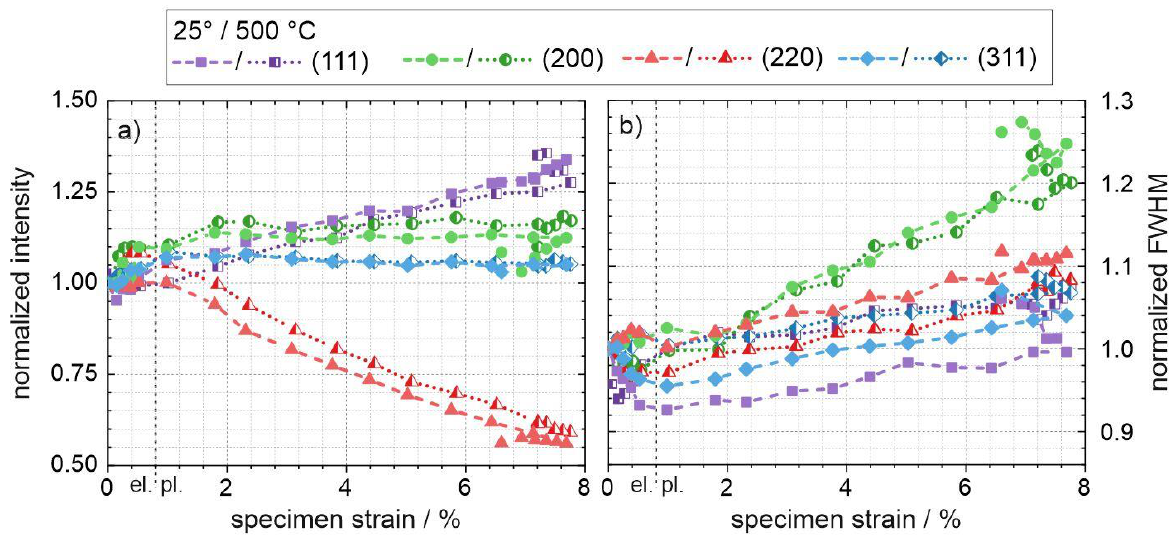
Figure 5. ( a ) Normalized peak intensity and ( b ) normalized full width at half maximum (FWHM) of peaks in different crystallographic orientations depending on the specimen (engineering) strain.